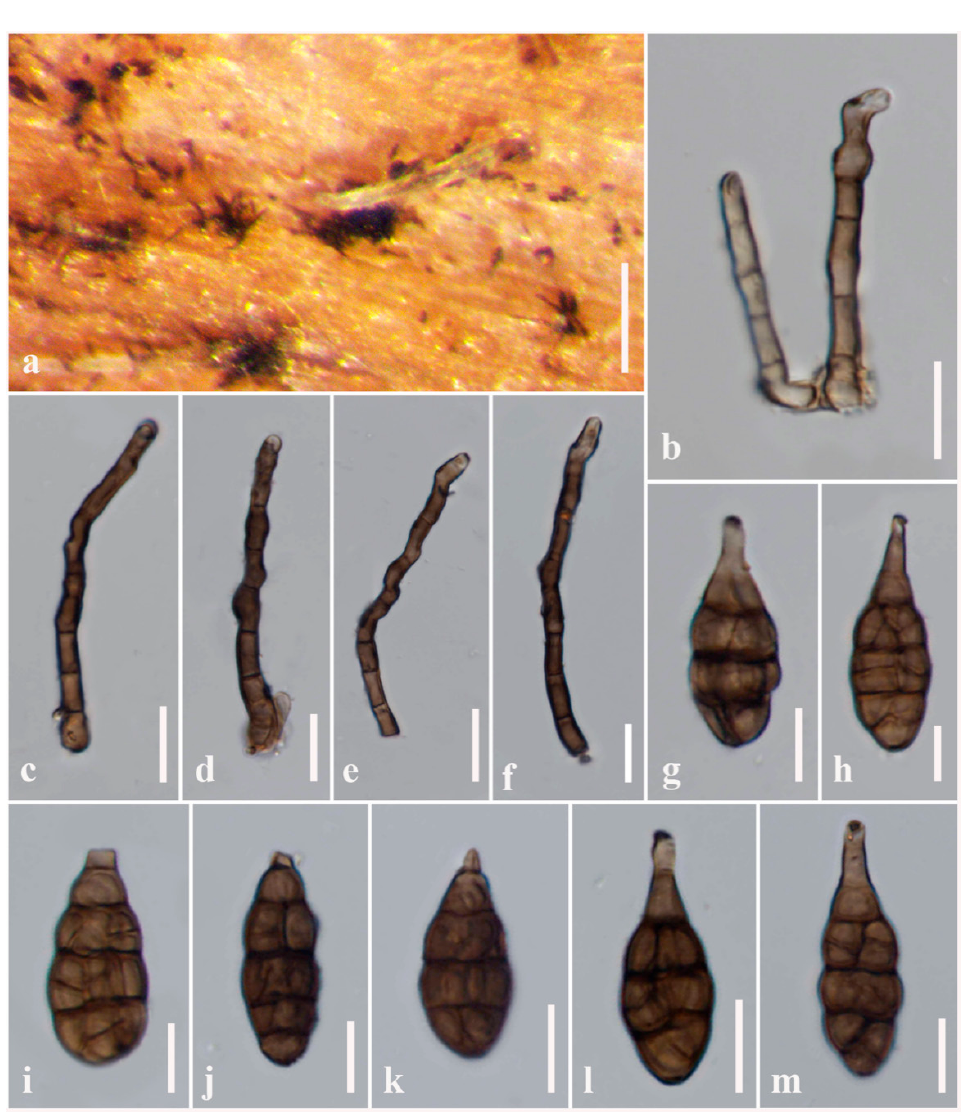
Figure 6. Alternaria rostroconidia (MFLU 21-0318, holotype). ( a ) Colonies on dead stems of Arabis sp; ( b – f ) Conidiophores bearing conidiogenous cells ( g – m ) Conidia. Scale bars: ( a ) = 200 µm, ( e ) = 50 µm, ( b , d , f ) = 30 µm, ( c , g – m ) = 20 µm.